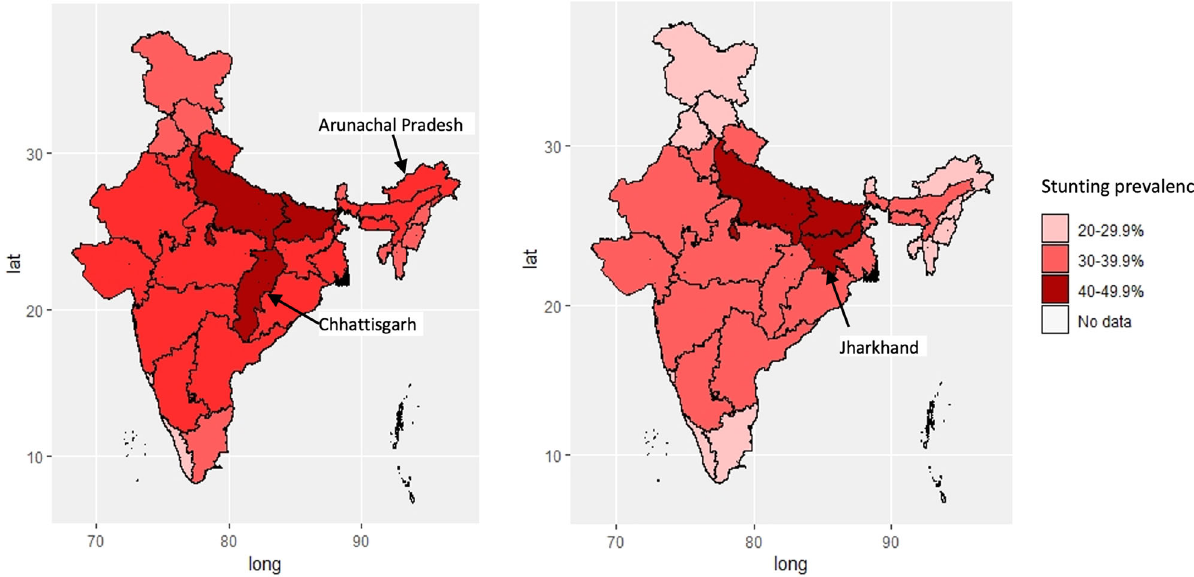
Fig. 1 | State-based stunting prevalence in <5-year-old children in two succes- sive National Family Health Surveys: NFHS-3 (2005; left panel) and NFHS-4 (2015;rightpanel). Thespatialdistributionofreductioninstuntingiscomparable across states, except for Chhattisgarh and Arunachal Pradesh. While Chhattisgarh